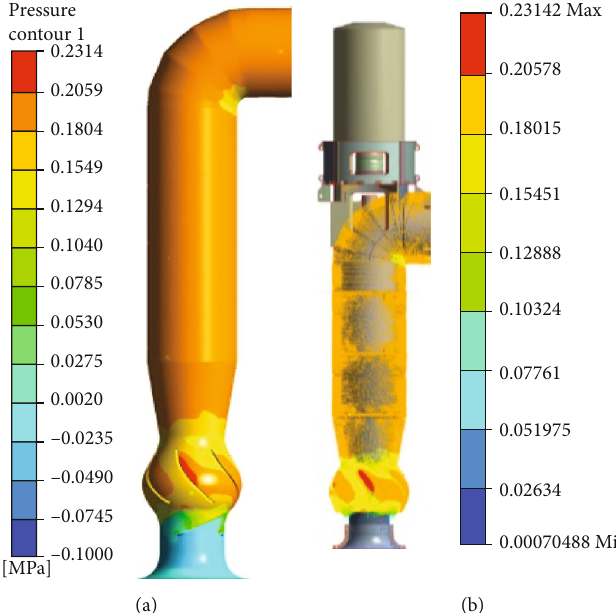
Figure 5: Pressure contours from CFD model to structural model: (a) CFD model; (b) structural model after pressure